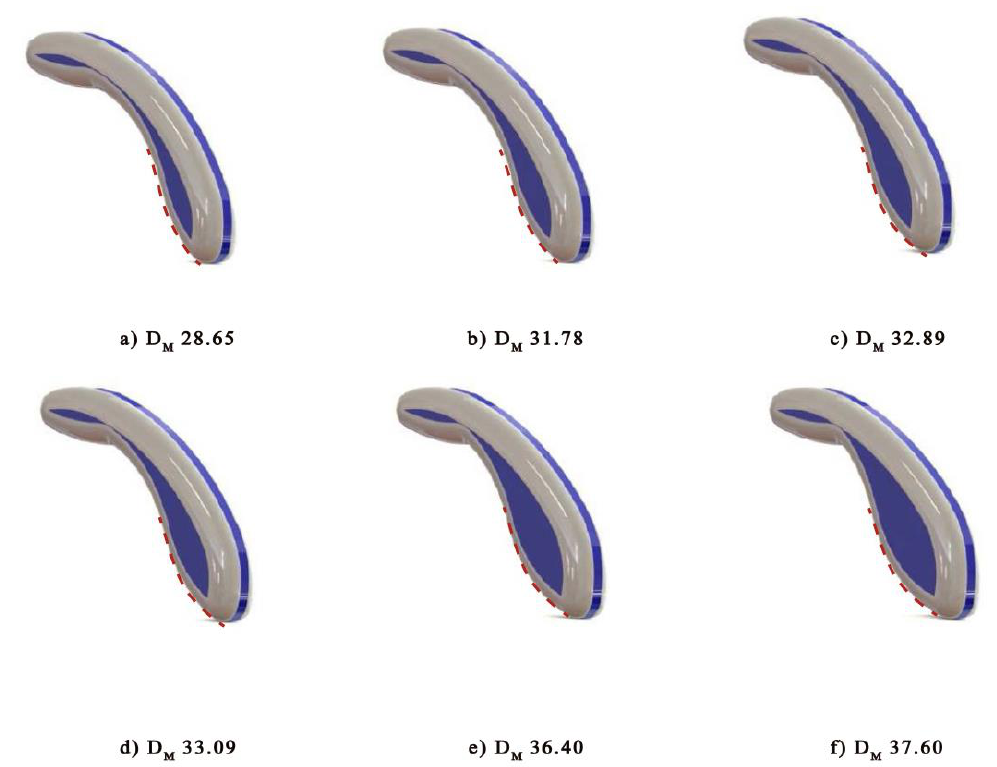
Figure 5. Custom 3D Computer Architectural Drawings (CAD) models of the surgical handle depending on each surgeon ’ s PLM measurement.